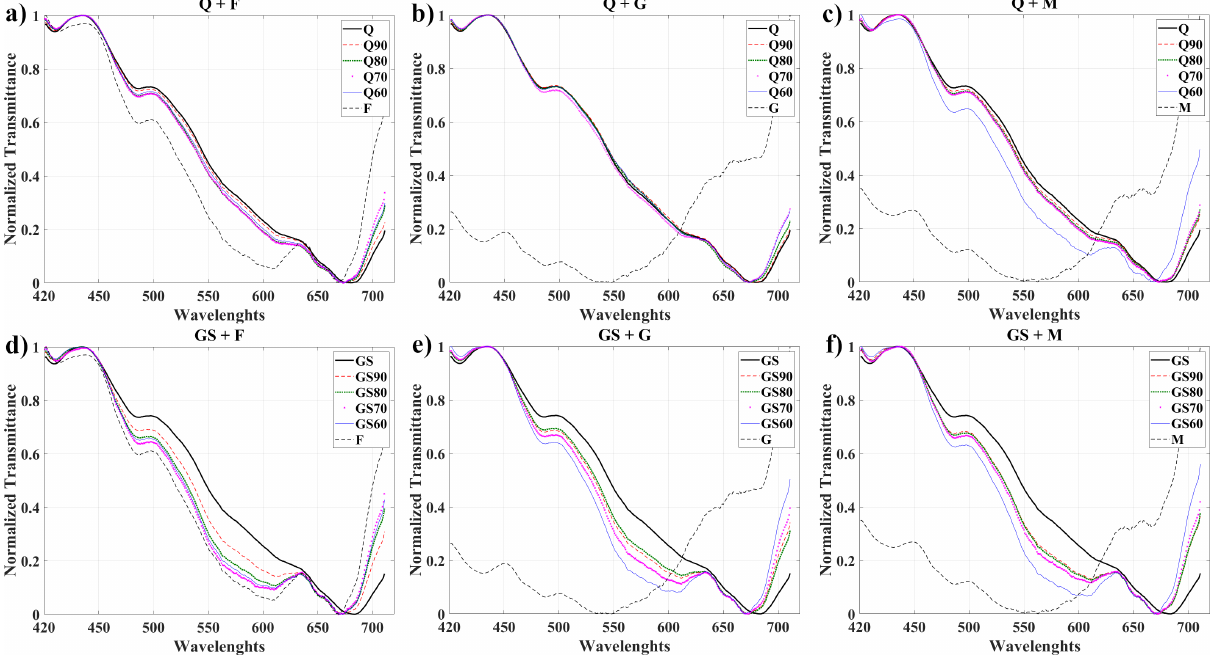
Figure 6. The transmittance curves were obtained from hyperspectral microscopy imaging. From ( a – f ) are the Q and GS honey curves with different concentration levels using F, G, and M syrups,